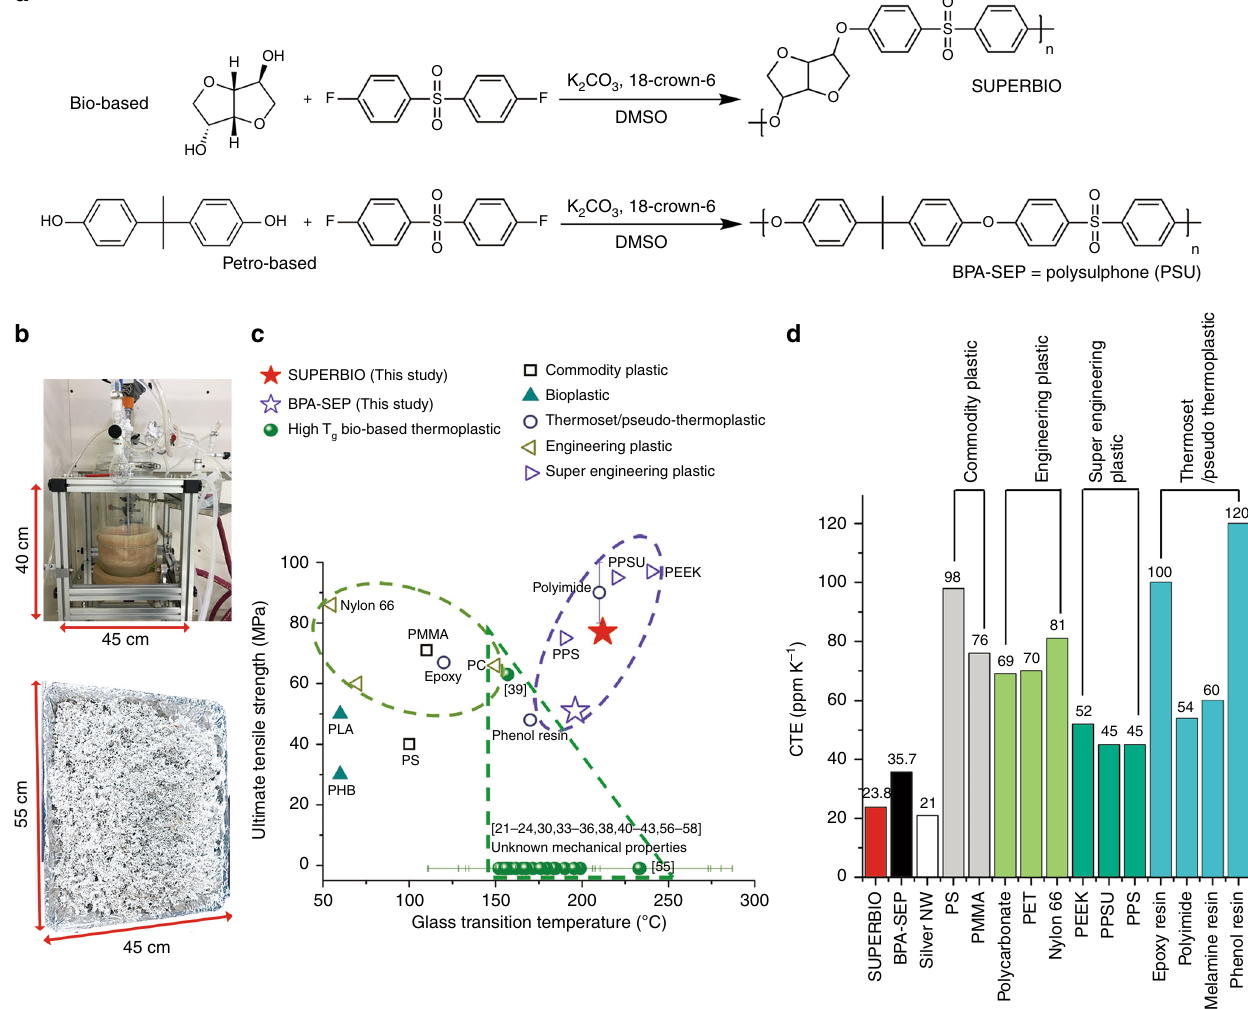
Fig. 1 Preparation and thermal/mechanical properties of the bio-based super engineering plastic. a Synthetic scheme of (top) ISB- and (bottom) BPA-based poly(arylene ether)s, which are designated as SUPERBIO and BPA-SEP, respectively. b Photograph of the polymerisation reactor at 1-kg-scale, and the SUPERBIO product. c Ashby plot of ultimate tensile strength versus glass transition temperature. d Coef fi cient of thermal expansion of petrochemical plastics/thermosets/ pseudo-thermoplastics, bio-based high T g thermoplastics, SUPERBIO, and BPA-SEP at 30 – 80